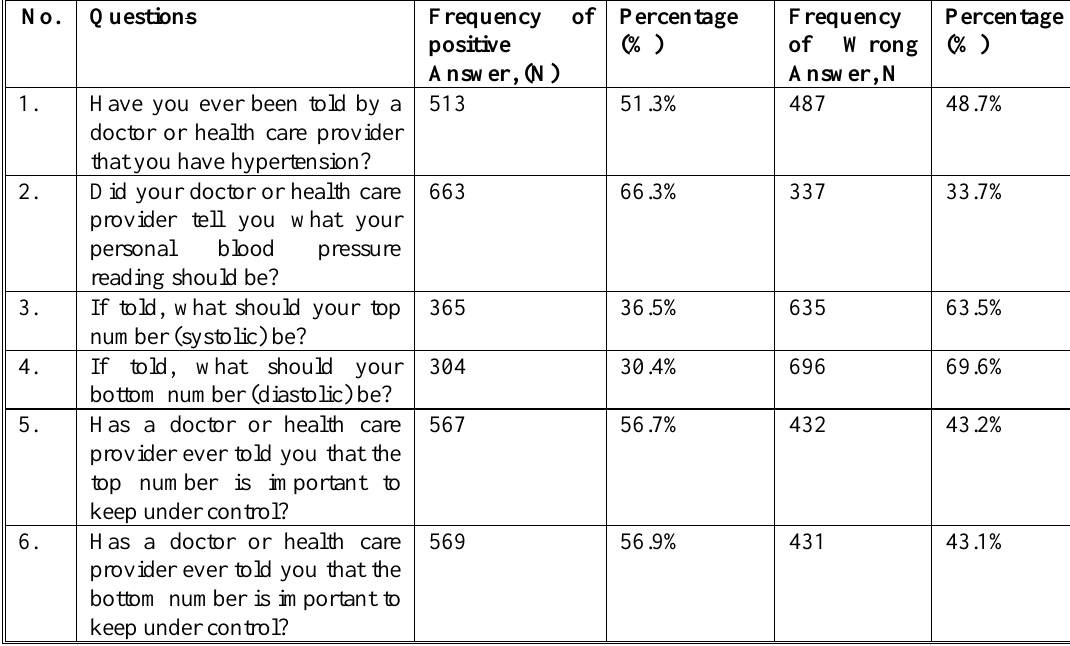
Table 2. Awareness about Hypertension among Respondents (N=1000)